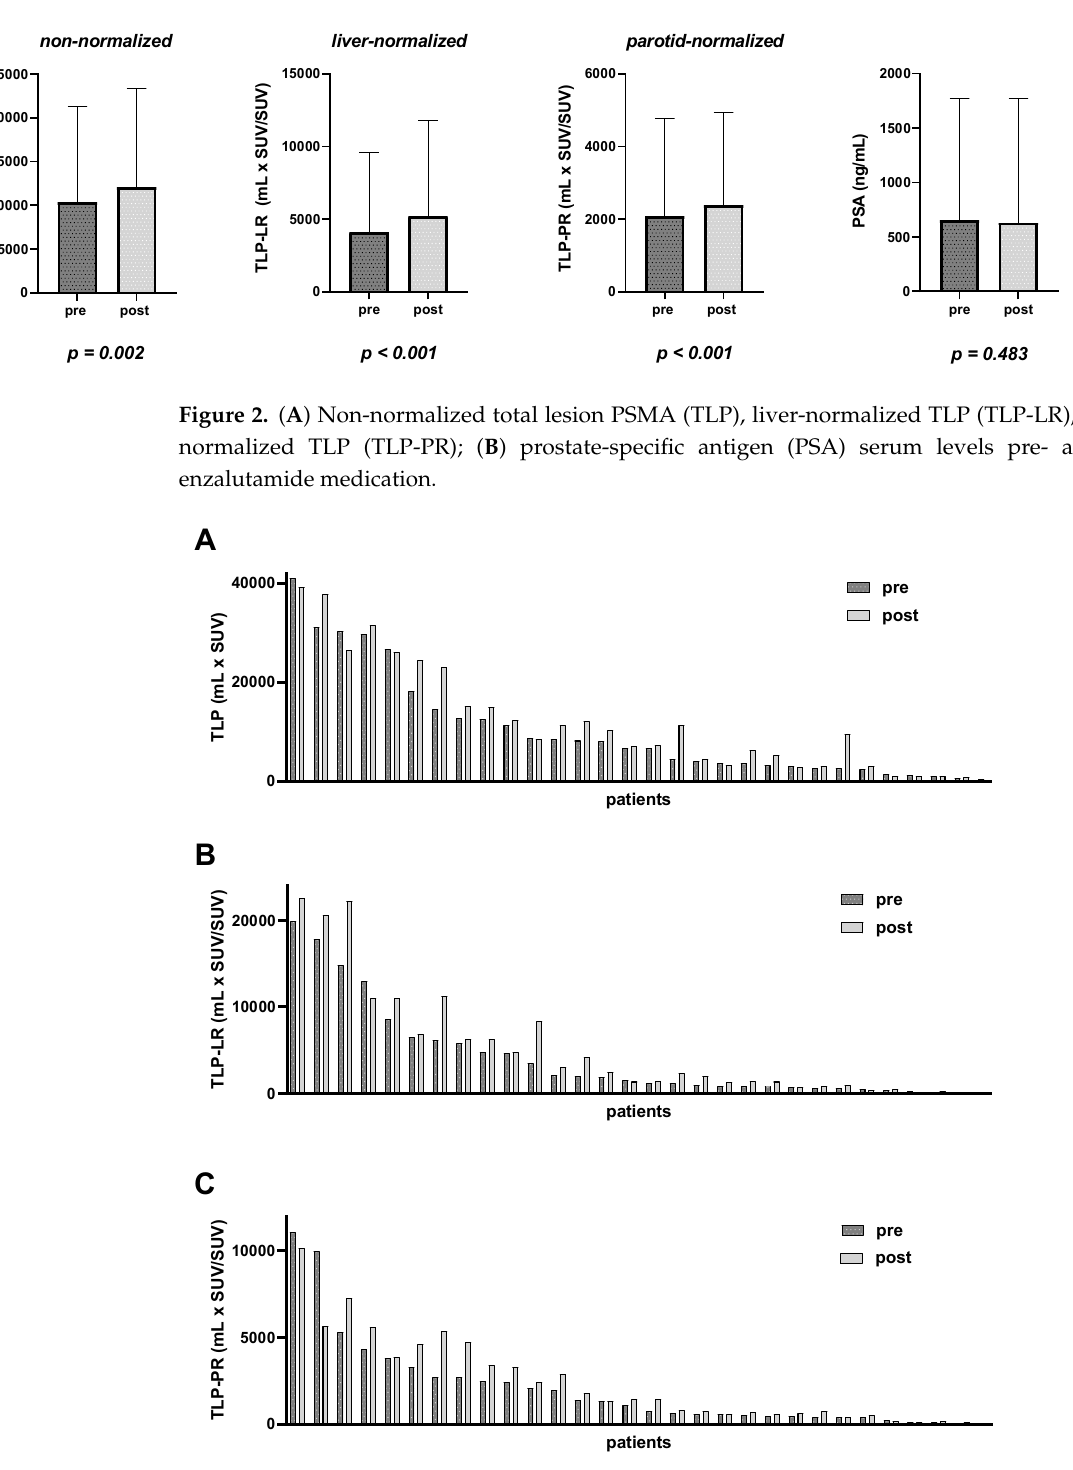
Figure 3. Waterfall plots of individual ( A ) non-normalized total lesion PSMA (TLP), ( B ) liver- normalized TLP (TLP-LR) and ( C ) parotid-normalized TLP (TLP-PR) values pre- and post- enzalutamide medication.